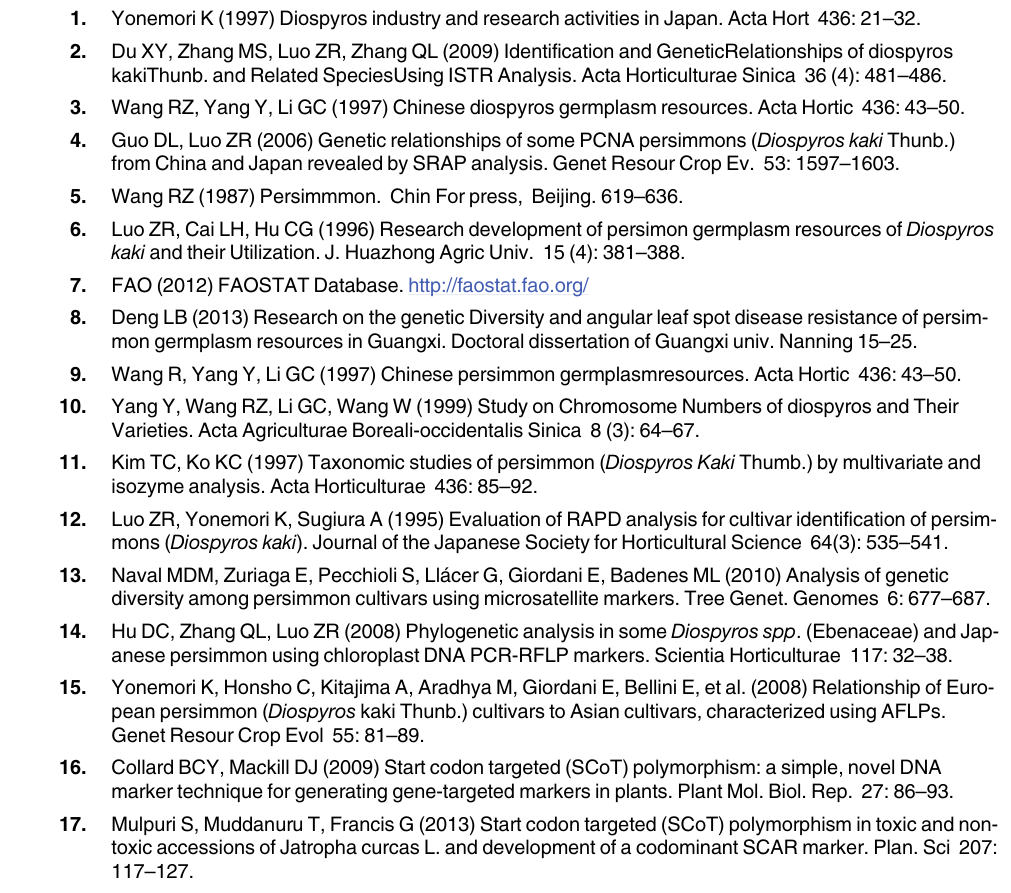
S5 Table. Genetic distances and geographical distances between natural diospyros popula- tions in